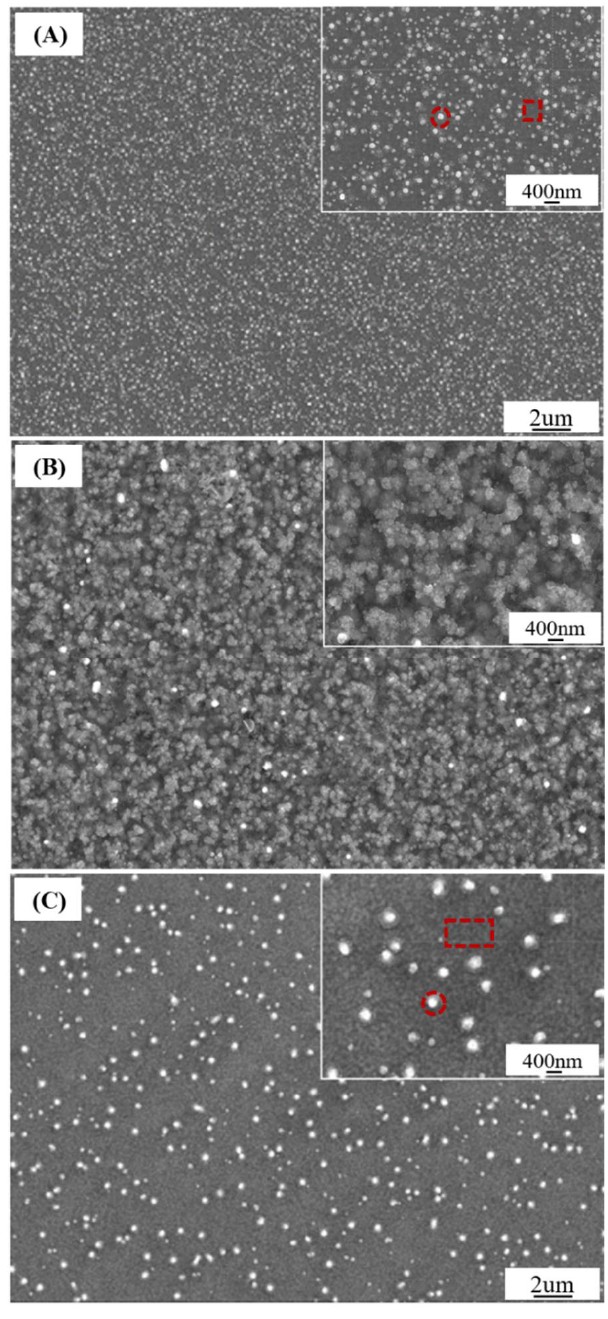
Figure 4. Secondary electron images of low vacuum pyrolysis films: ( A ) 15 ◦ C/min; ( B ) 25 ◦ C/min. Secondary electron images of conventional pyrolysis films: ( C ) 0.5 ◦ C/min. The elemental proportions of red circle and red box in Figure (5B,5D).